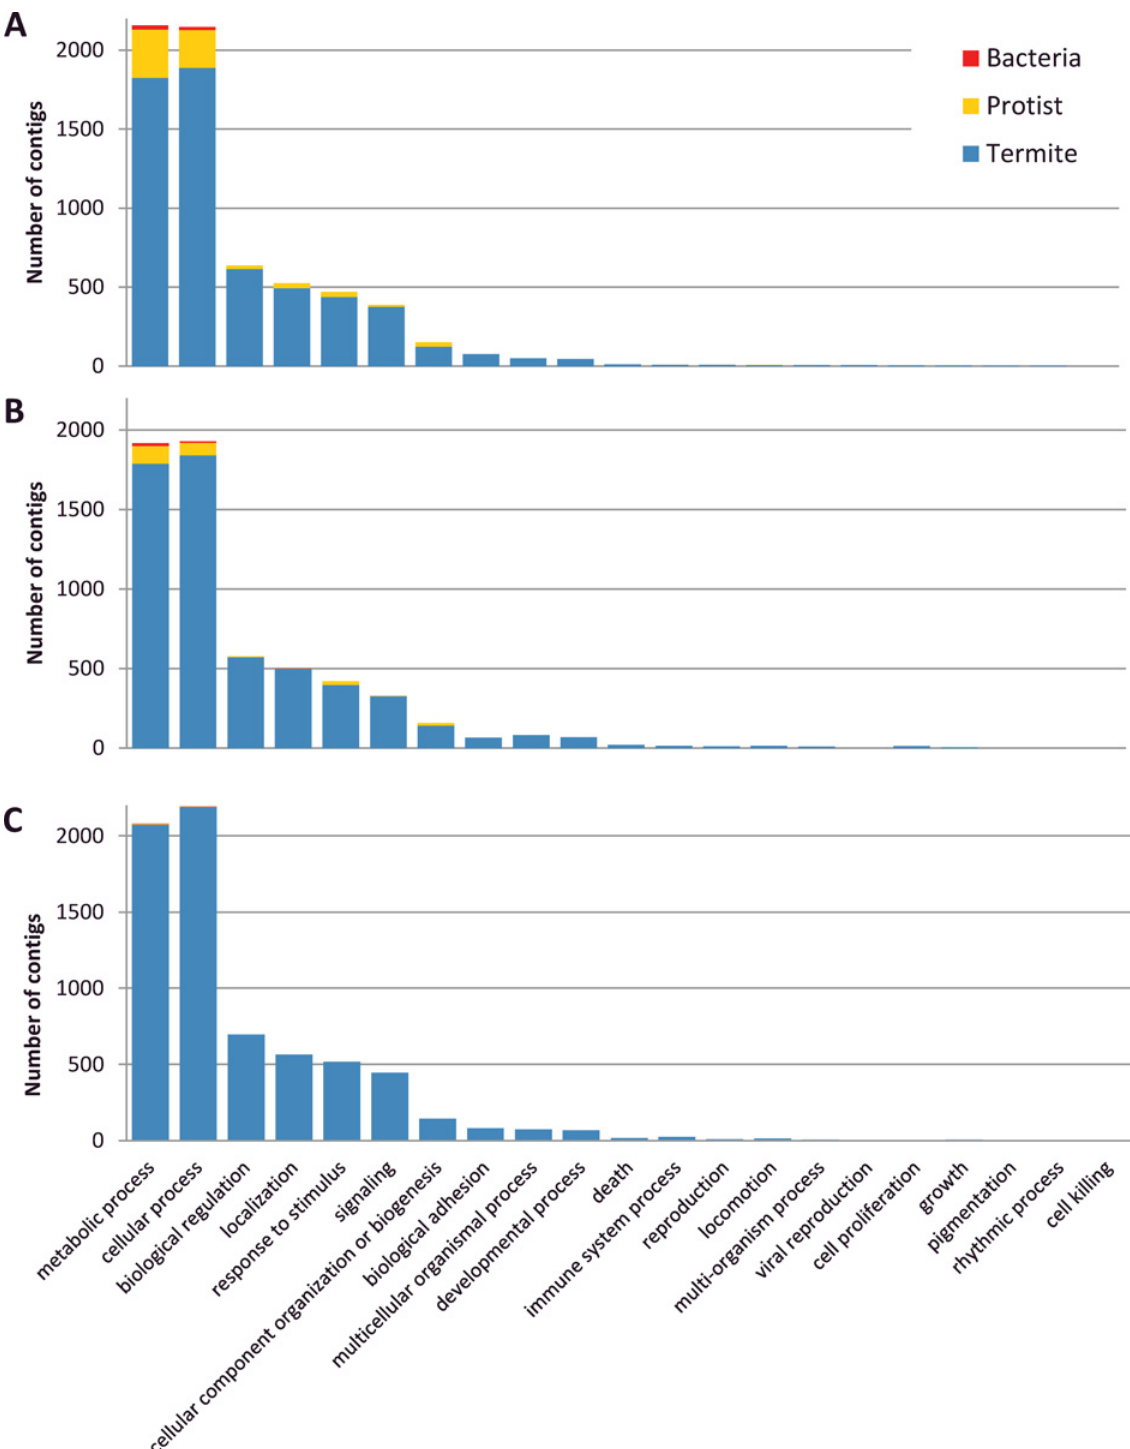
Fig 3. Gene Ontology analysis of Biological Processes (GO level 2). A: R . flavipes . B: R . grassei , C: R . lucifugus .